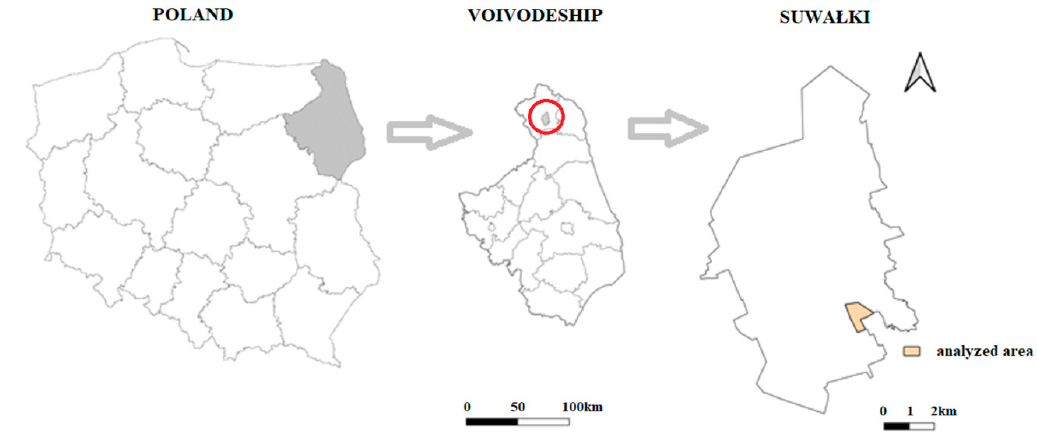
Figure 5. Location of the study area. Source: Prepared by the author.